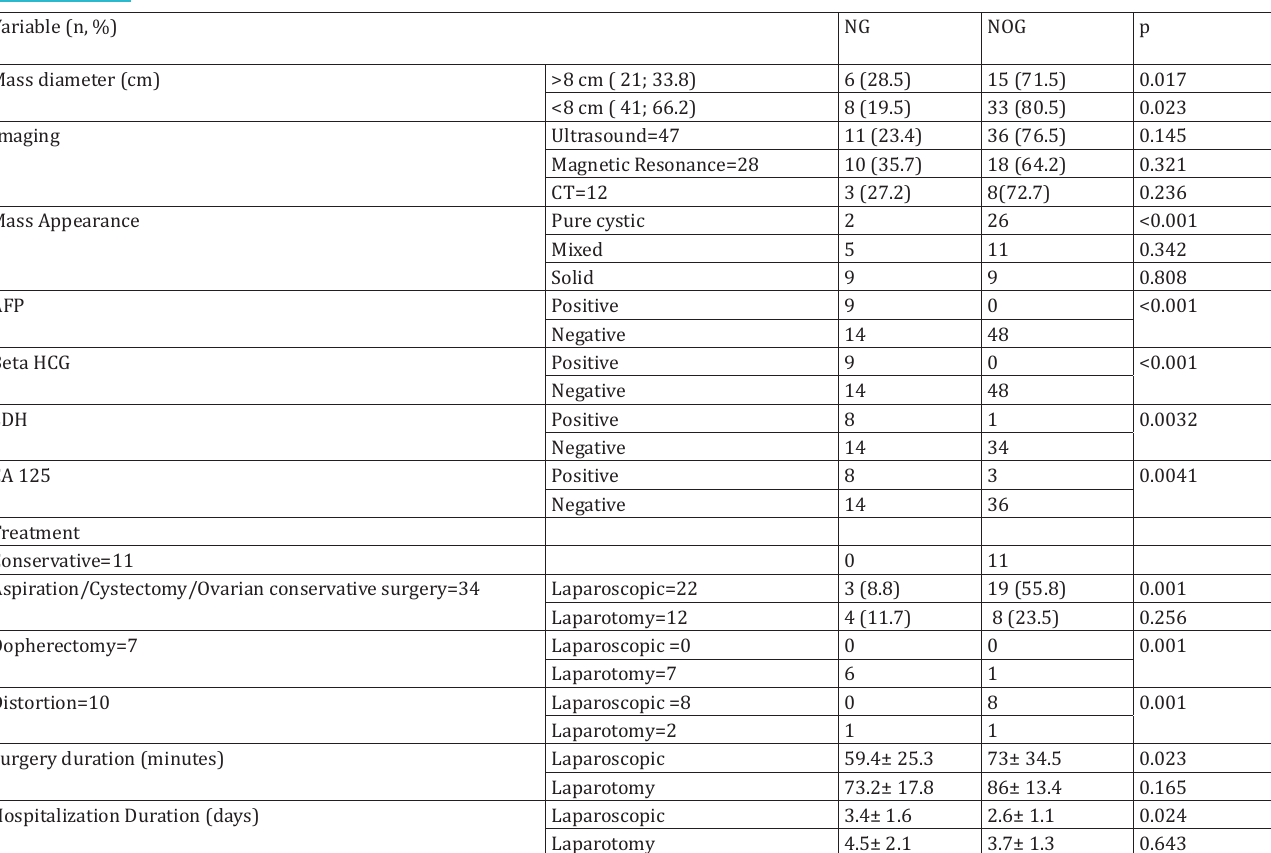
Treatment outcomes of ovarian